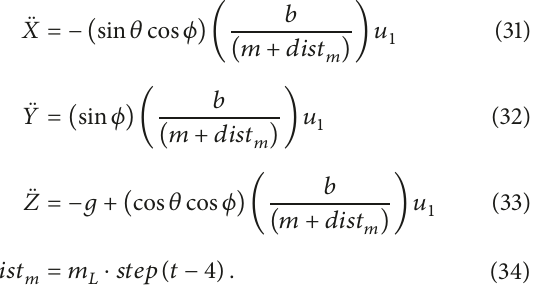
tackle disturbances, as it can be seen in the following